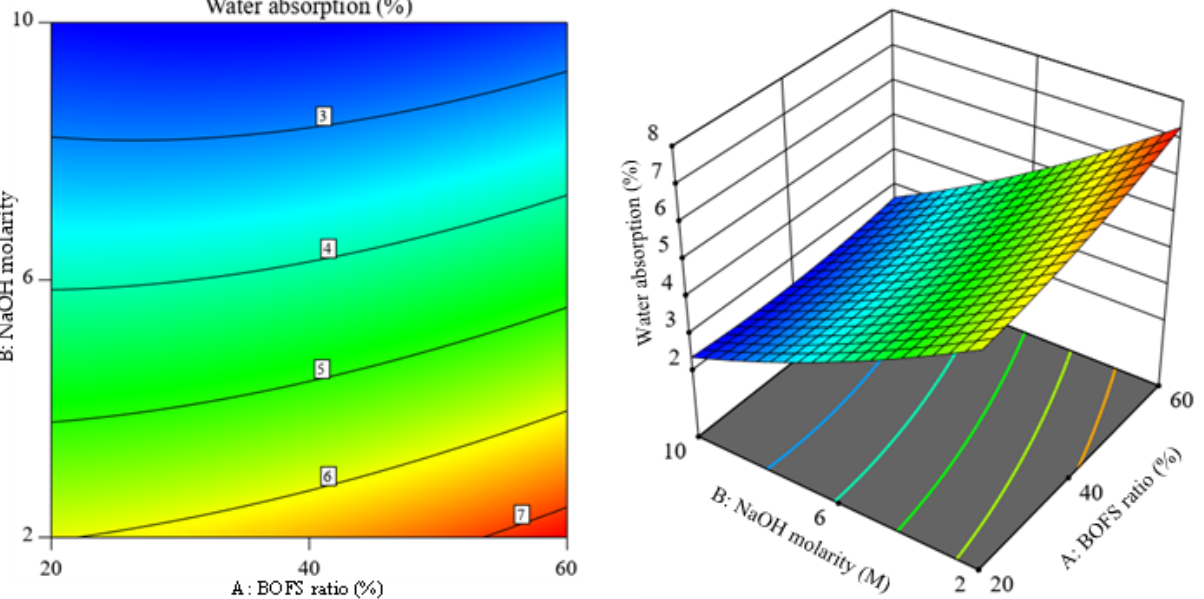
Figure 16. Contour plot and 3D response surface of water absorption. Table 5. The goodness-of-fit assessment of response